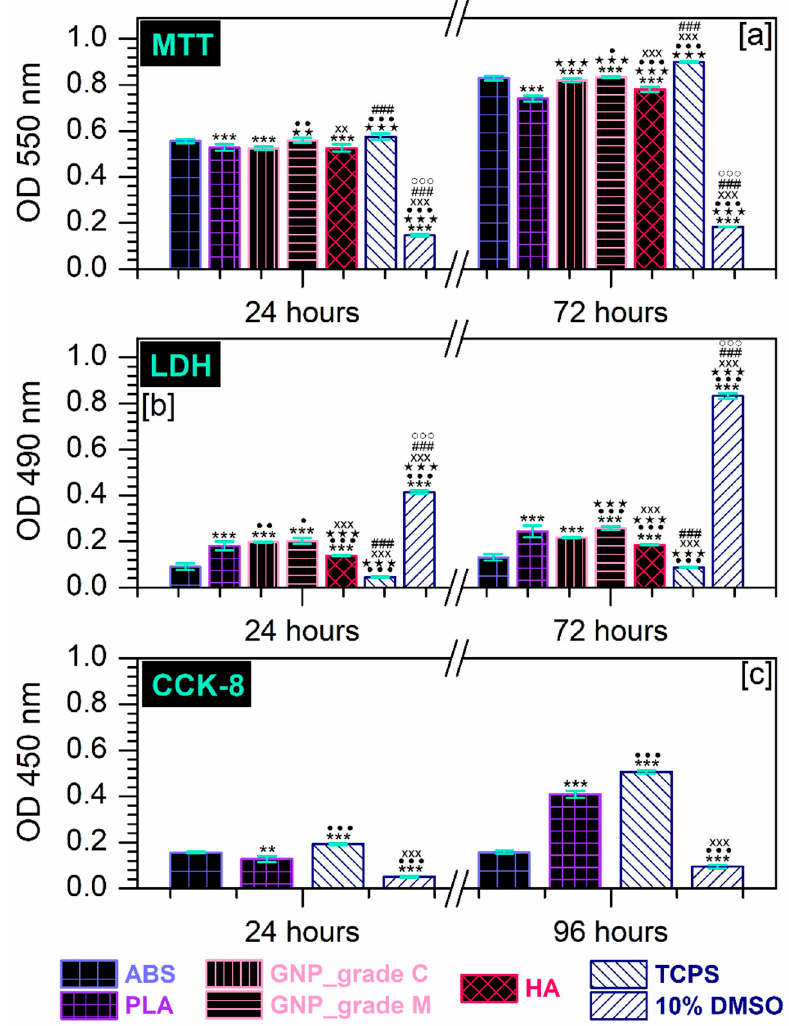
Figure 5. ( a ) Extract e ff ect on the degree of survival and proliferation potential of MC3T3-E1 pre- osteoblasts at 24 h and 72 h after seeding, as assessed by the MTT assay ( *** p < 0.001 vs. ABS ; ★★★